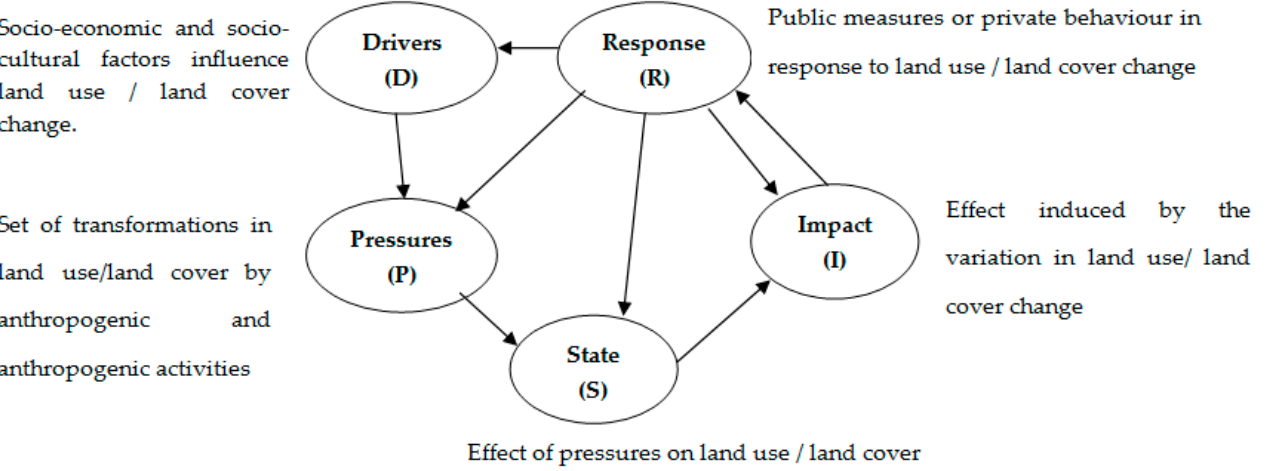
Figure 3. Adaptation of the DPSIR framework to land use/land cover change.